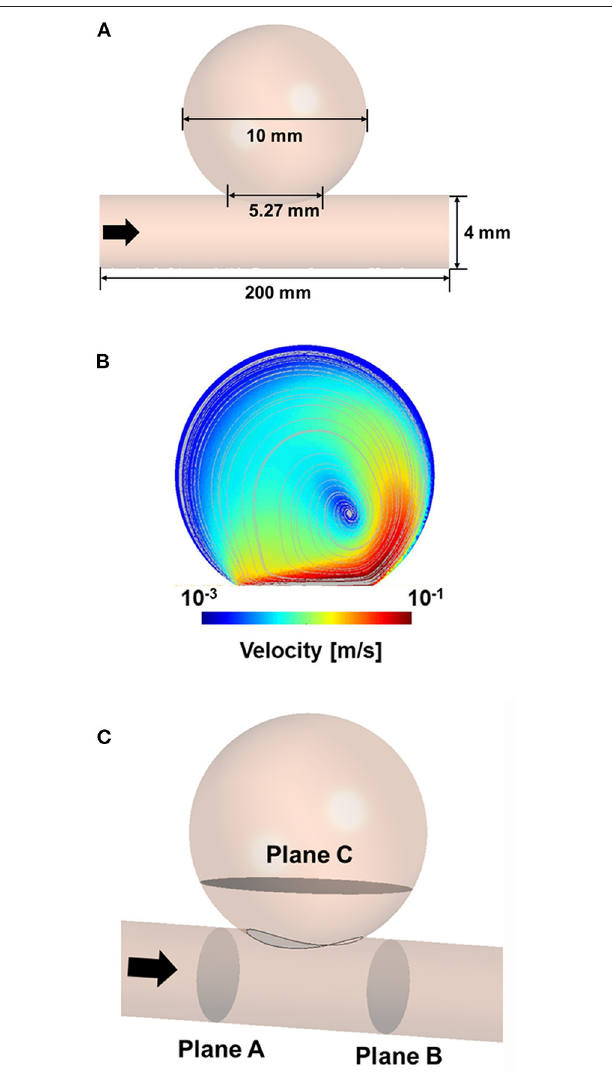
FIGURE 1 | Three-dimensional model of idealized sidewall-type aneurysm for CFD analysis (A) . CFD velocity and streamline results for CFD process validation (B) . Position of the planes for extracting the hemodynamic parameters (C) . CFD, computational fluid